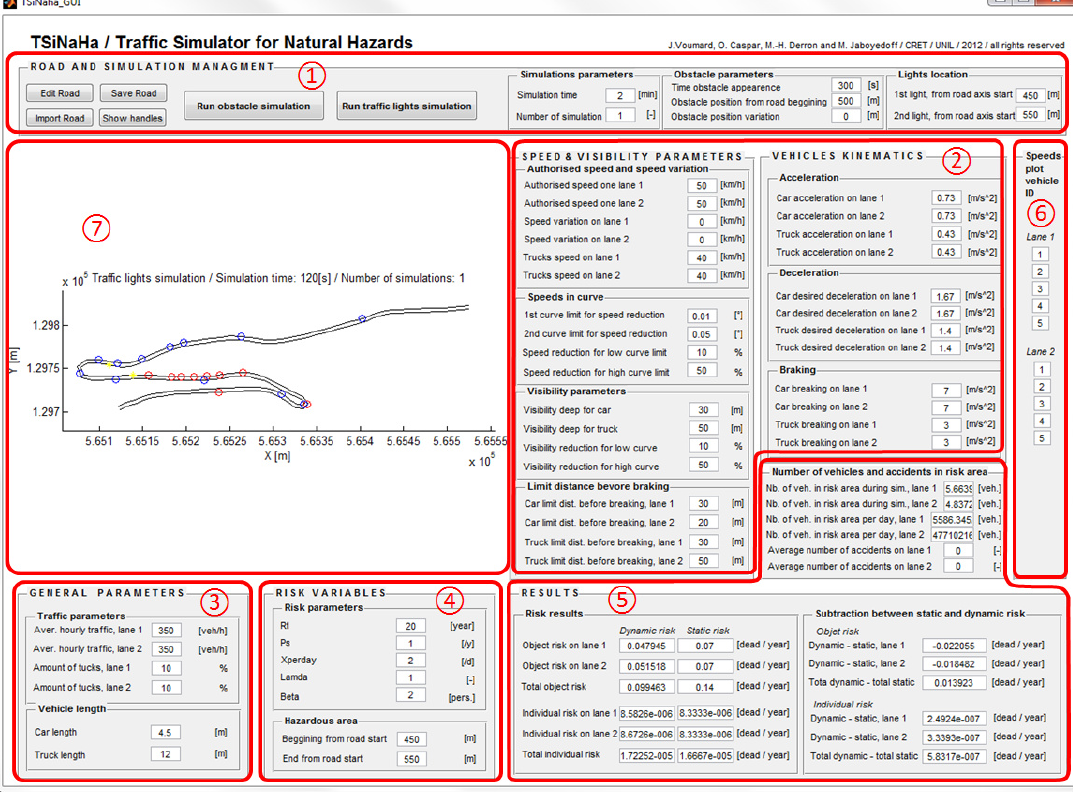
Fig. 2. Graphic user interface (GUI) of the dynamic traffic simulator in MATLAB ® . The GUI is divide into seven boxes: (1) simulation and road management importation of a road section to choose scenario type and to define traffic lights and obstacle location as well as simulation time; (2) speed and visibility parameters, introduction of the different parameters of vehicle’s kinematics (acceleration, breaking), speed limit and speed reduction in curve linked with visibility parameters; (3) general traffic parameters and vehicle lengths; (4) start and end of the hazardous area location and static parameters used for the risk equation; (5) results of the simulation appear here with number of vehicles in the hazardous area, number of accidents and dynamic and static risk results and comparison; (6) vehicle identifiers to be plotted in the speed graphic; (7) graph of the road section, the hazardous area, traffic lights and obstacle locations and vehicles’